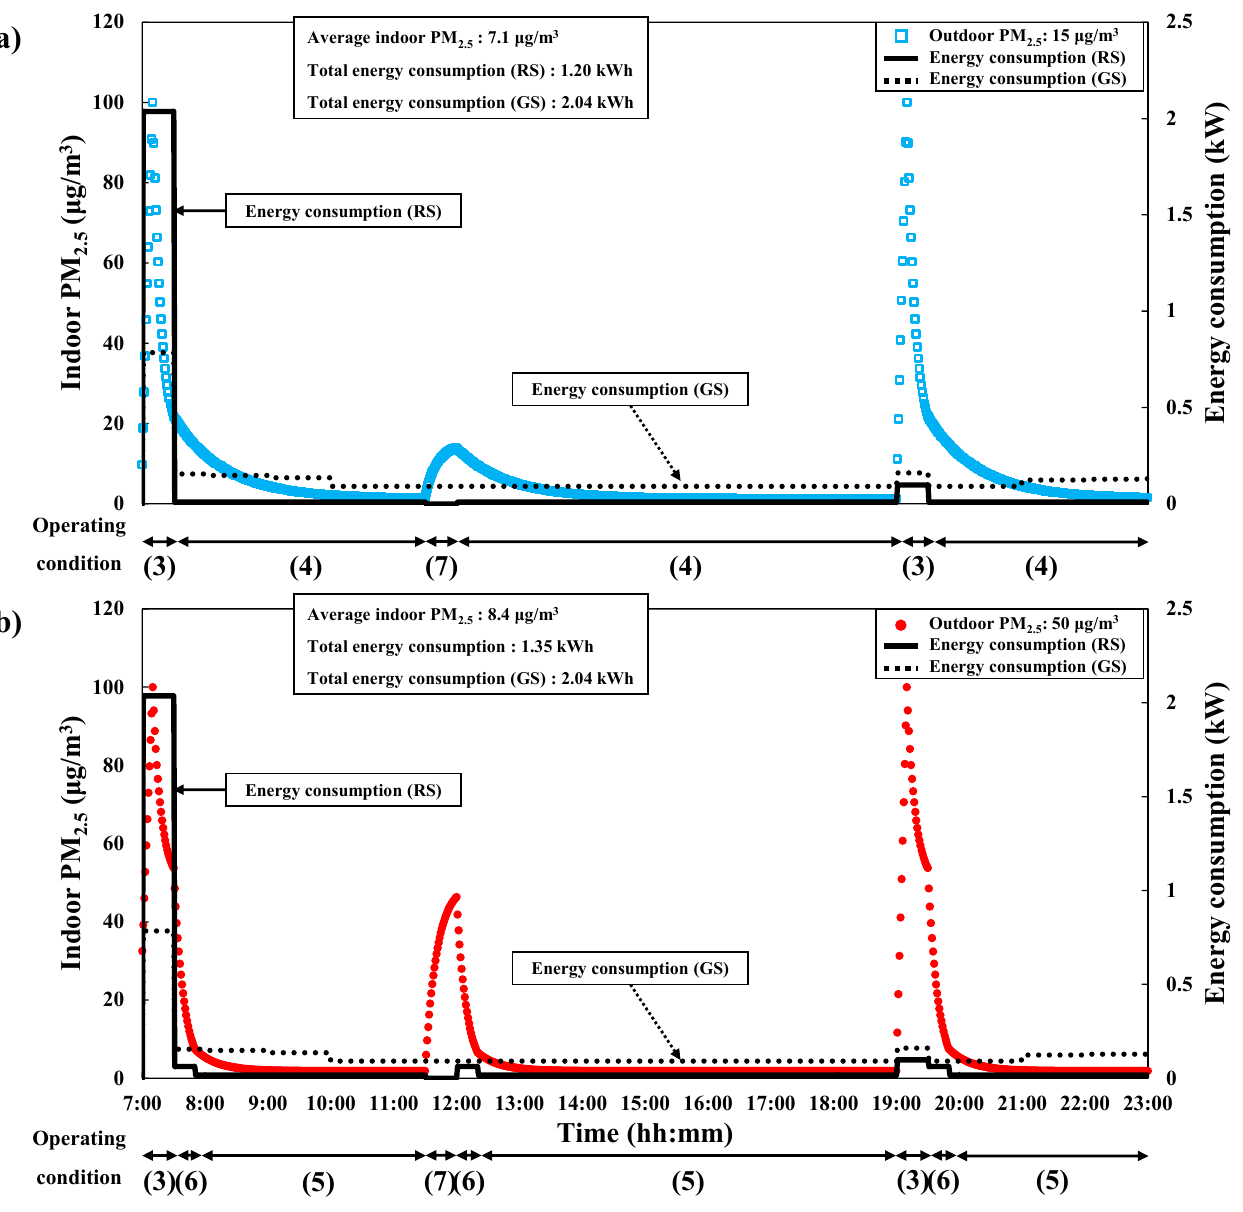
Figure 5. Changes in PM 2.5 concentration and energy consumption with time to maintain average PM 2.5 < 10 µ g/m 3 under the energy consumption reduction scenario in spring/autumn (GS: general scenario, RS: reduction scenario). ( a ) Outdoor PM 2.5 : 15 µ g/m 3 . ( b ) Outdoor PM 2.5 : 50 µ g/m 3 .